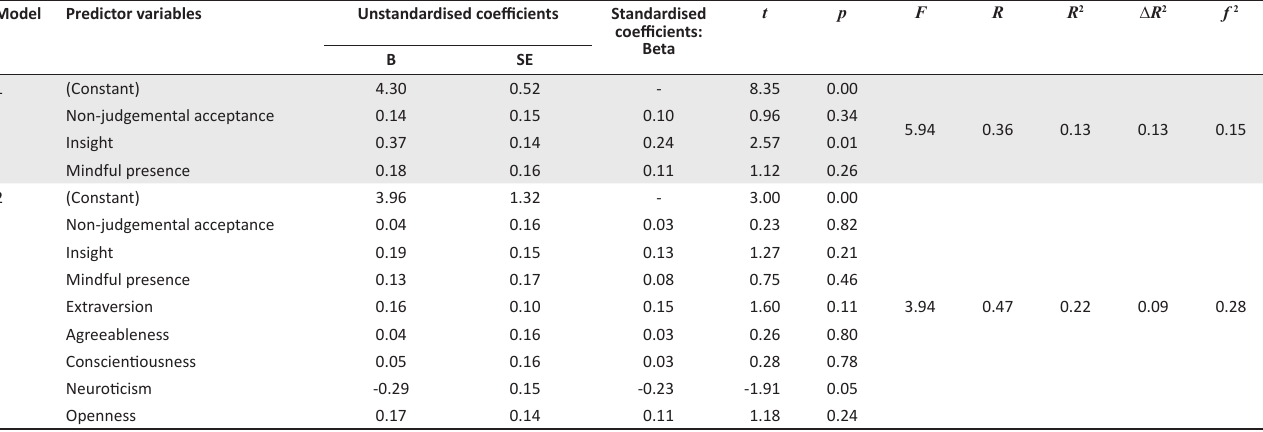
TABLE 4: Multiple regression analysis with comprehensibility as a dependent